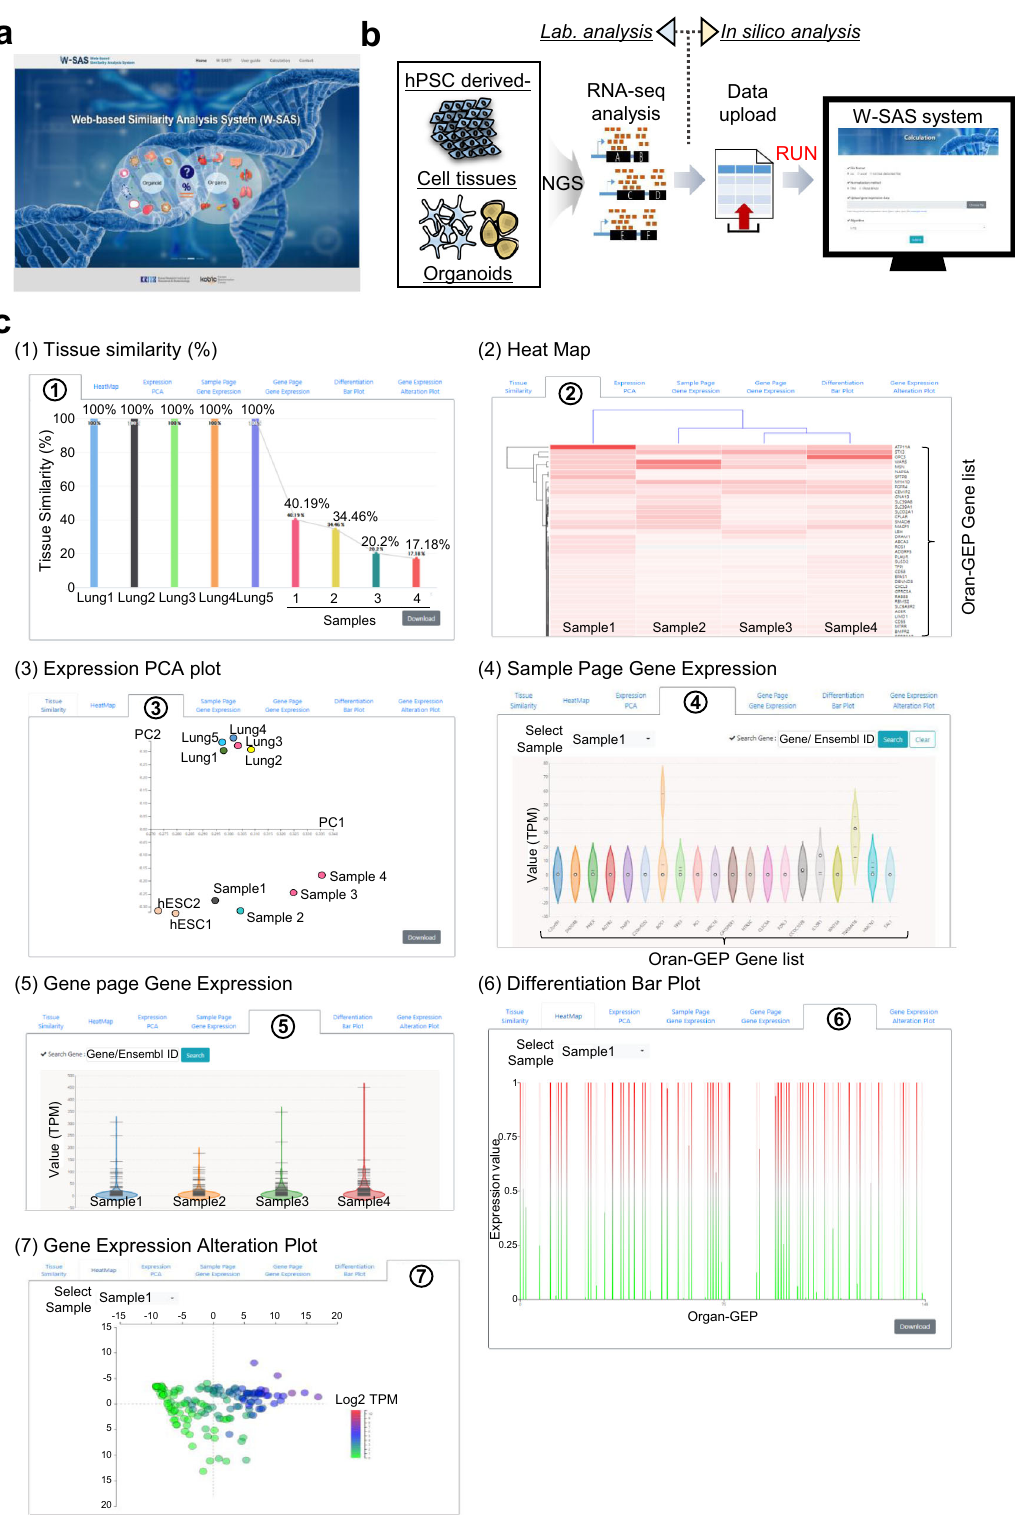
Fig. 6 W-SAS is a user-friendly interface for the quantitative calculation system for the similarity of hPSC-derived organoids and cells to organs. a Main page of W-SAS. b A work fl ow for W-SAS. Using the RNA-seq results of hPSC-derived organoids and cells, W-SAS can calculate the similarity of each organoid and cell to the human target organ. c Results page showing similarity of the hPSC-derived organoids. The results are divided into fi ve parts: similarity percentage (1), heat map (2), PCA plot (3), gene expression panel of Organ-GEPs or samples (4 and 5), differentiation bar plot (6), and GEAP